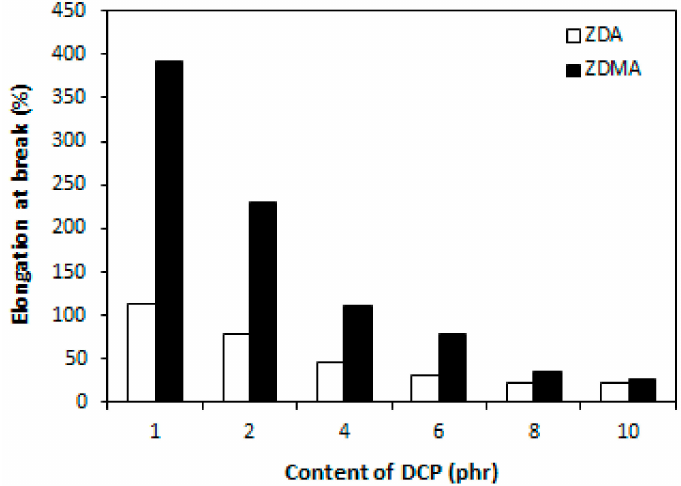
Figure 14. Influence of peroxide content on hardness of composites.